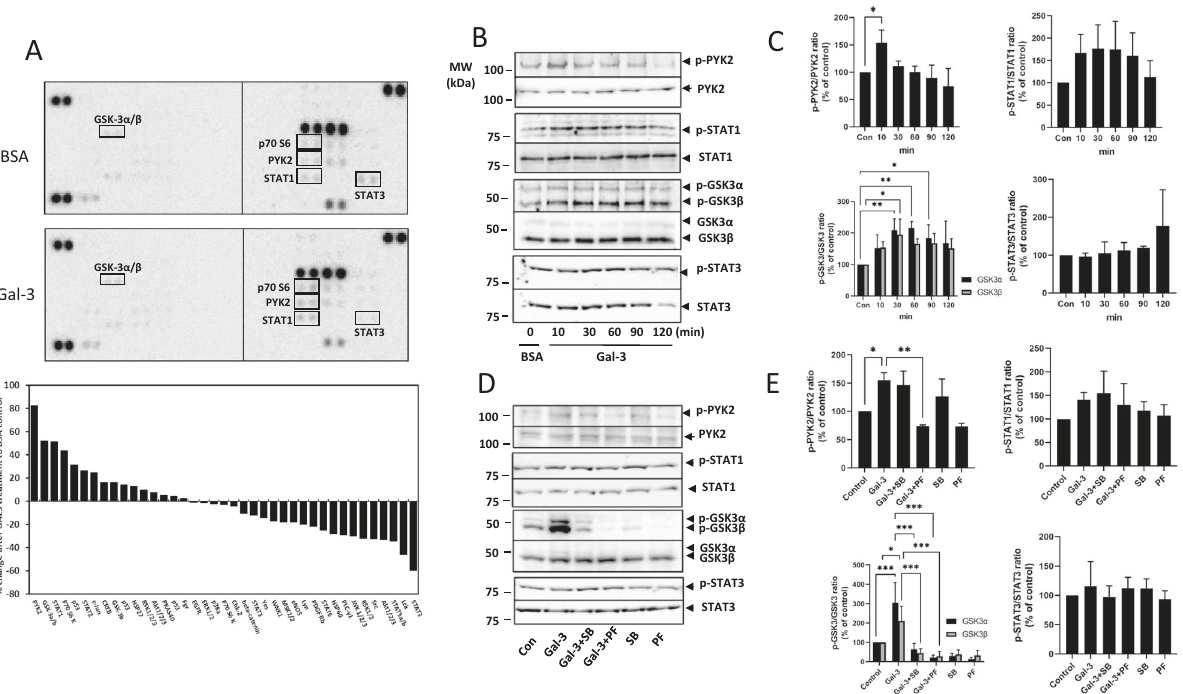
Fig. 7 Galectin-3 expression induces activation of PYK2, STAT1 and GSK3 α / β signalling. Expression of 37 protein kinases in SW620 cells in response to 10 µg/ml galectin-3 or BSA for 0.5 h was assessed by Proteome Pro fi ler Human Phospho-Kinase Array ( A , Percentage changes of the kinases in cell response to galectin-3 in comparison to control are shown at the bottom panel). The presence of galectin-3 increases the phosphorylation of PYK2, GSK3 α / β , and STAT1 and decreases phosphorylation of STAT3. SW620 cells treated with 10 µg/ml galectin-3 for different times were assessed by immunoblotting using antibodies against p-PYK2, p-STAT-1, p-GSK3 α / β or p-STAT-3 ( B ). The blots were striped and reprobed with antibodies against PYK2, STAT-1, GSK3 α / β or STAT-3. The band density was quanti fi ed and expressed as percentages of phospho-/non-phosphorylated proteins ( C ). In D and E , SW620 cells were treated with 10 µg/ml galectin-3 or BSA followed by introduction of GSK3 α / β inhibitor SB 216763 (SB) or PKY2 inhibitor PF-431396 (PF) for 15 min and the levels of phosphorylated PYK2, STAT-1, GSK3 α / β or STAT-3 were analysed by immunoblotting. The blots were striped and reprobed with antibodies against PYK2, STAT-1, GSK3 α / β or STAT-3. The densities of the blots from three independent experiments were quanti fi ed and are expressed as the percentage of phosphorylated/non-phosphorylated levels of each protein. *** P < 0.001, ** P < 0.01, * P < 0.05